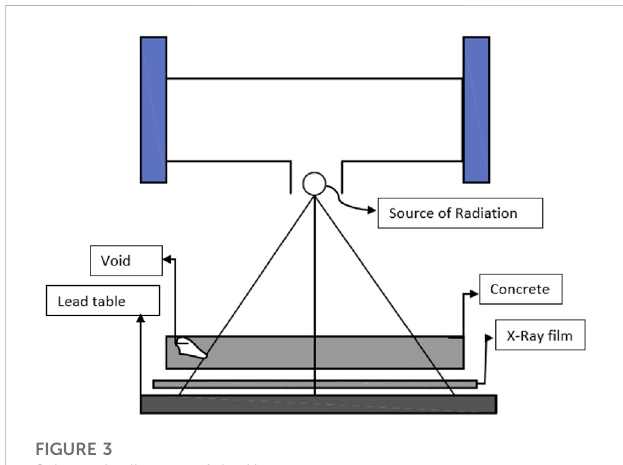
FIGURE 3 Schematic diagram of the X-ray test setup.